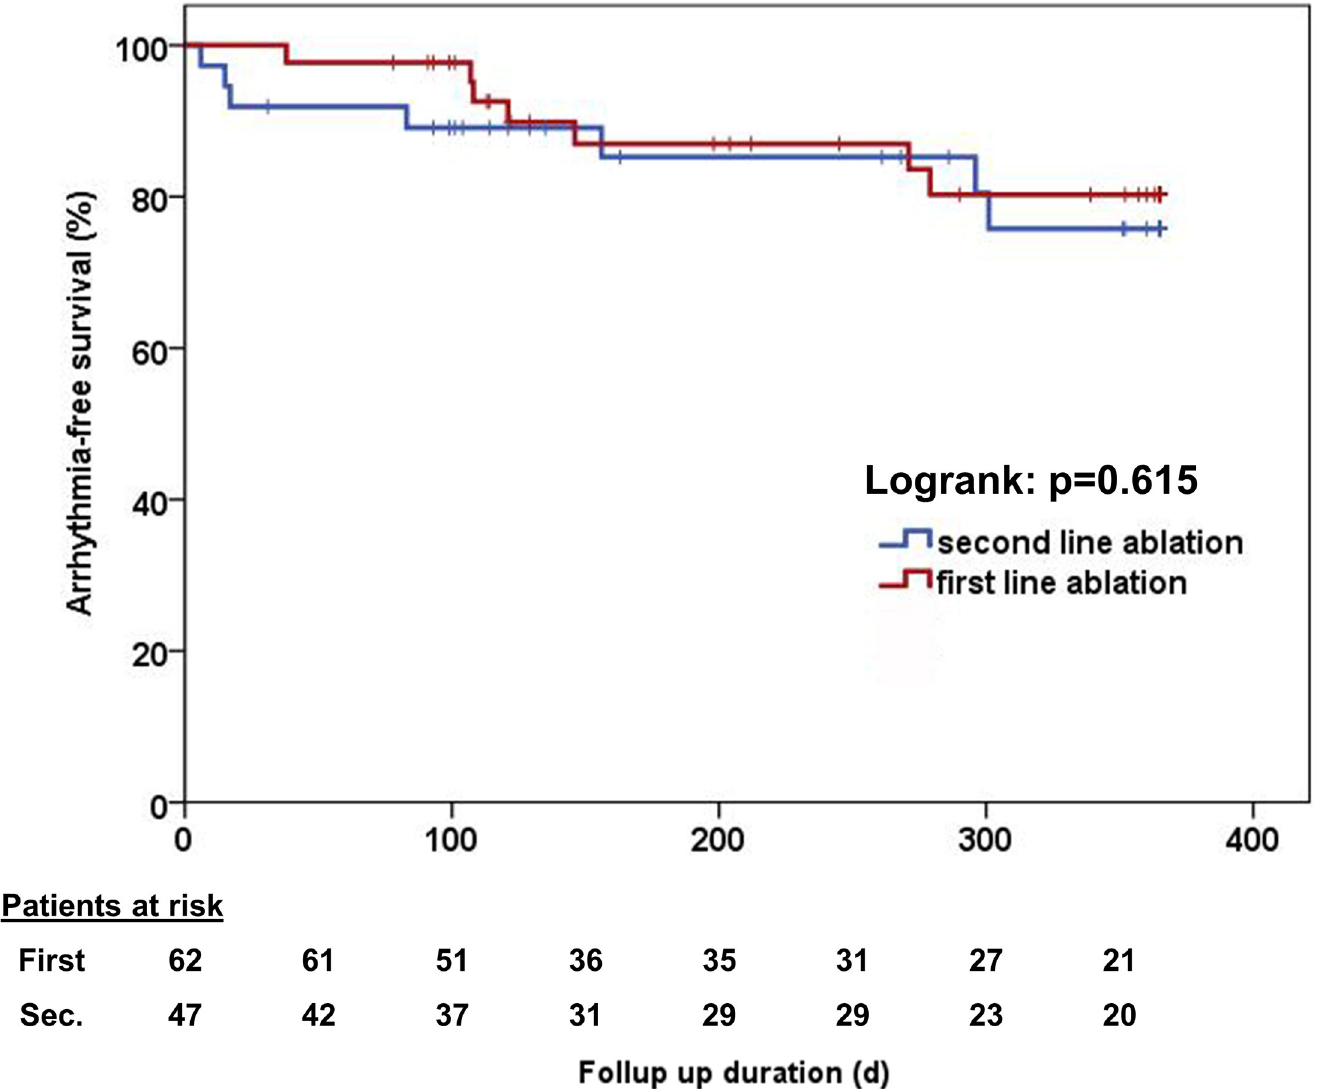
Fig 1. Single procedure success rate off antiarrhythmic drugs. There was no significant difference between patients who received ablation as a first or second line therapy (Log rank test: p = 0.615).